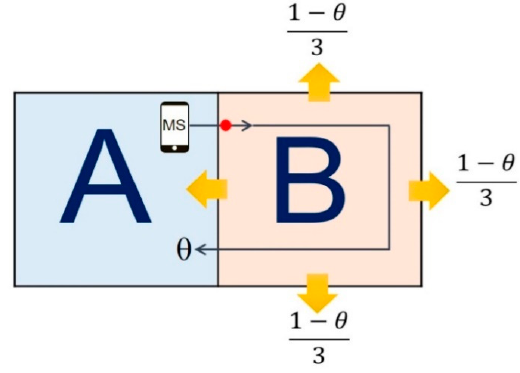
Figure 4. Inter-zone mobility model in 2ZR.